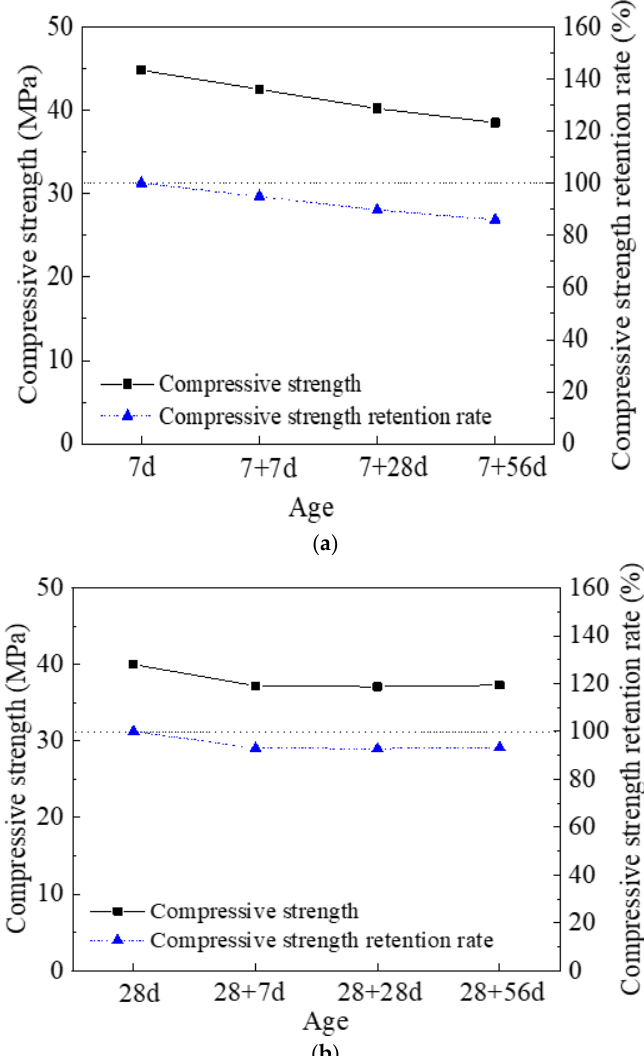
Figure 6. Compressive strength and its retention rate of HDMC with ( a ) 7 days and ( b ) 28 days of ambient curing (Note: the standard deviation is within 10% of the average value, which is also applicable to Figures